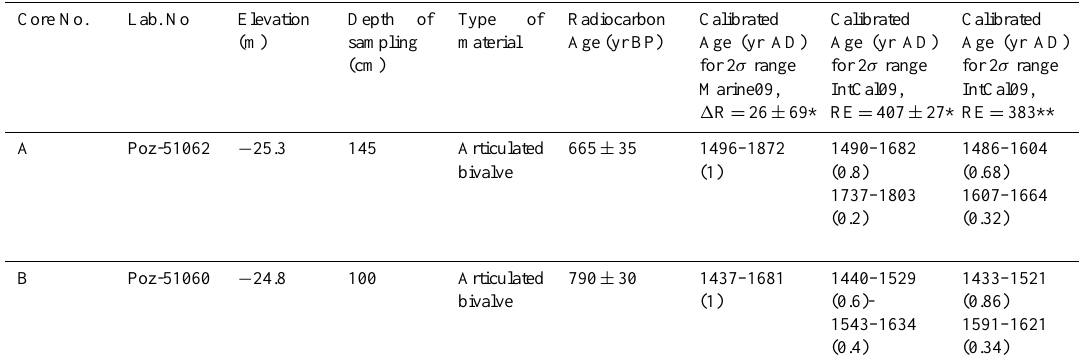
Table 2. AMS radiocarbon dating of the sediment cores. The 2 σ (95.4%) calibrated age ranges are based on the Marine09 curve with an average 1 R = 26 ± 69 14 C yr (Kuzmin et al., 2007; Olsson, 1980) and on IntCal09 curve with a reservoir effect (RE) of 407 ± 27 14 C yr subtracted with the probabilities shown in parentheses. For core location, see Fig. 3. Core No.